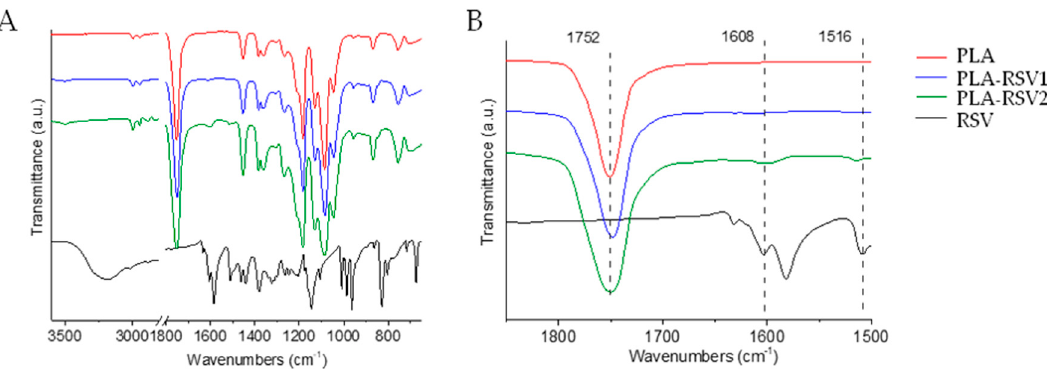
Figure 2. ( A ) FTIR-ATR spectra of RSV, neat PLA fibers, PLA fibers containing RSV1 and RSV2; ( B ) Zoom in the range of 2000–1400 cm − 1 .